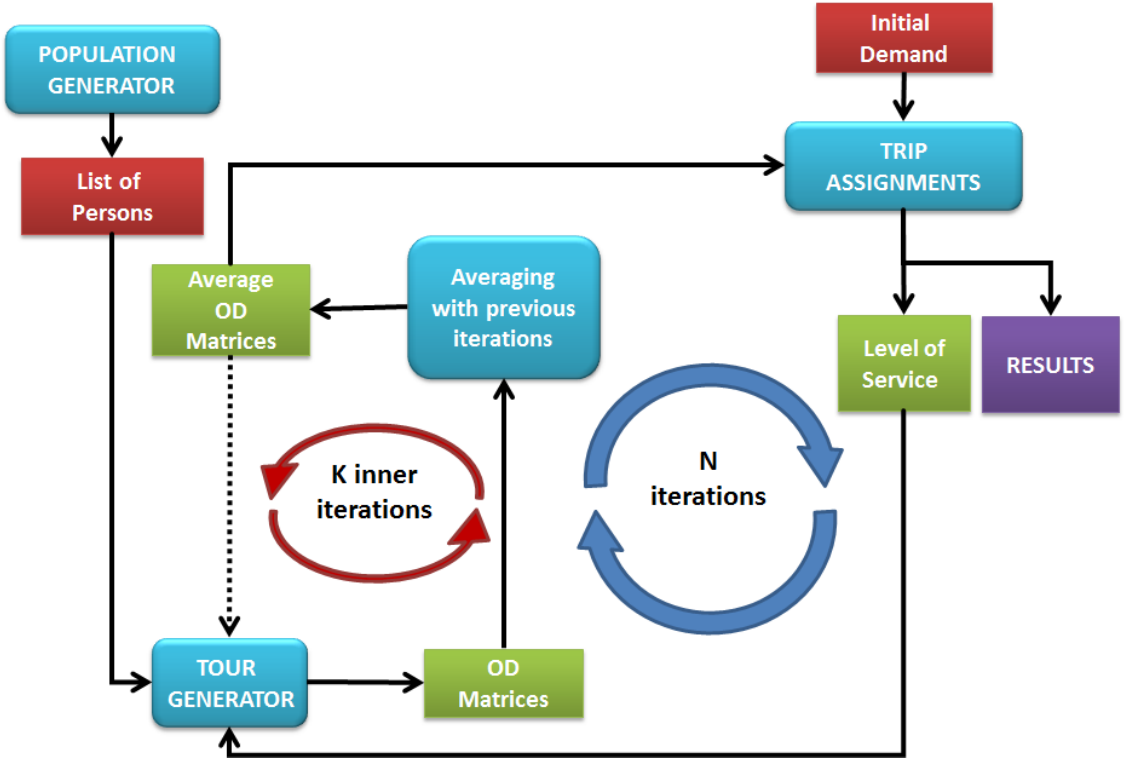
Figure 11. “Quasi- aggregation”